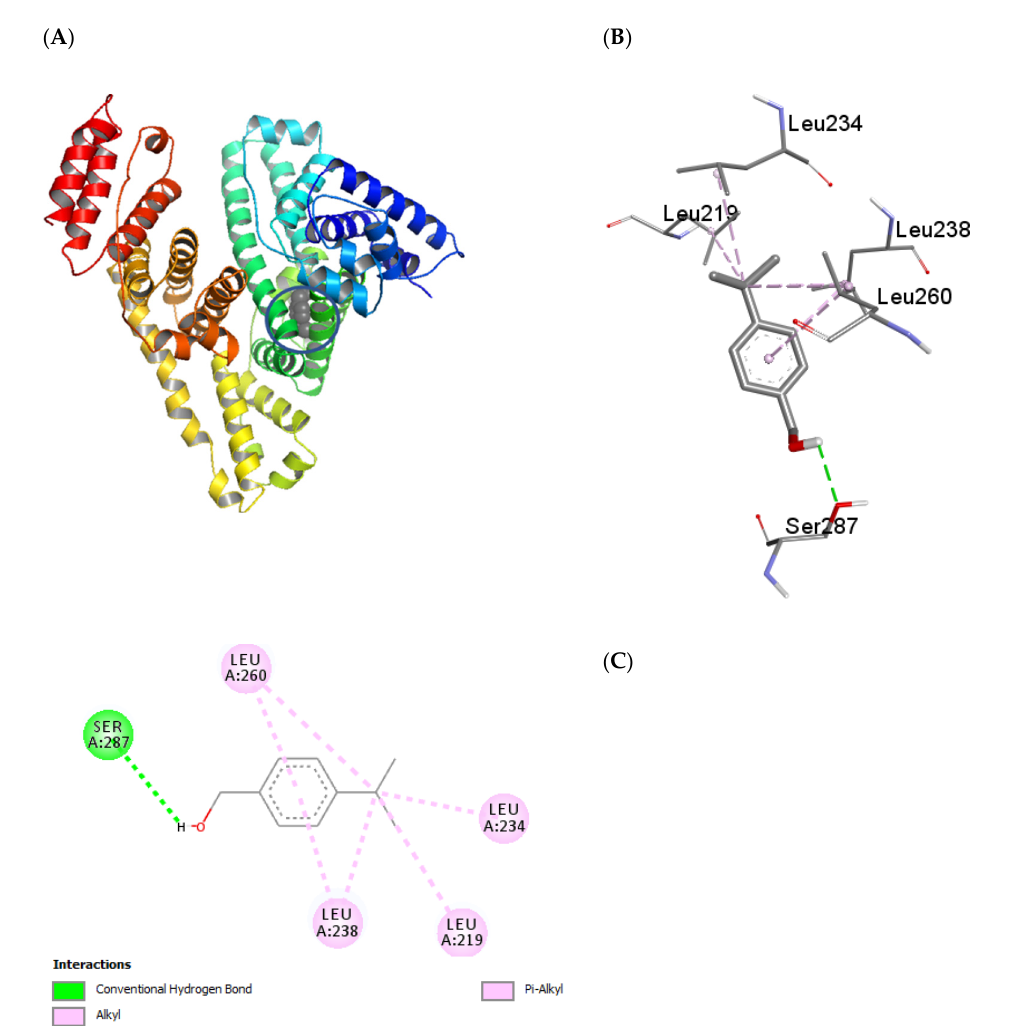
Figure 11. ( A ) Cluster analysis of interaction of cuminol with HSA ( B ) binding pocket amino acids ( C ) 2-D diagram showing the types of interactions